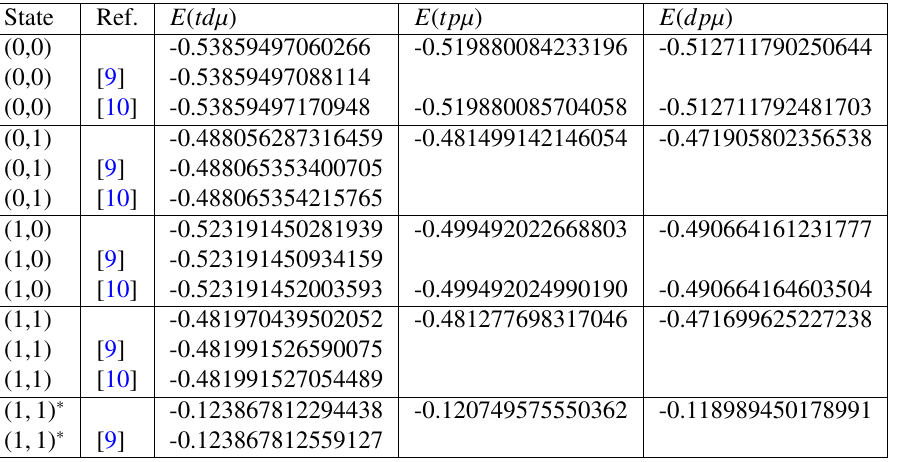
Table 1. Energies of the bound states of muonic molecular ions in muon-atomic units. The results are compared with ones obtaned early by V.I. Korobov [9] and A.M. Frolov [10] using an exponential basis. The designation of states corresponds to those used in [8, 10,